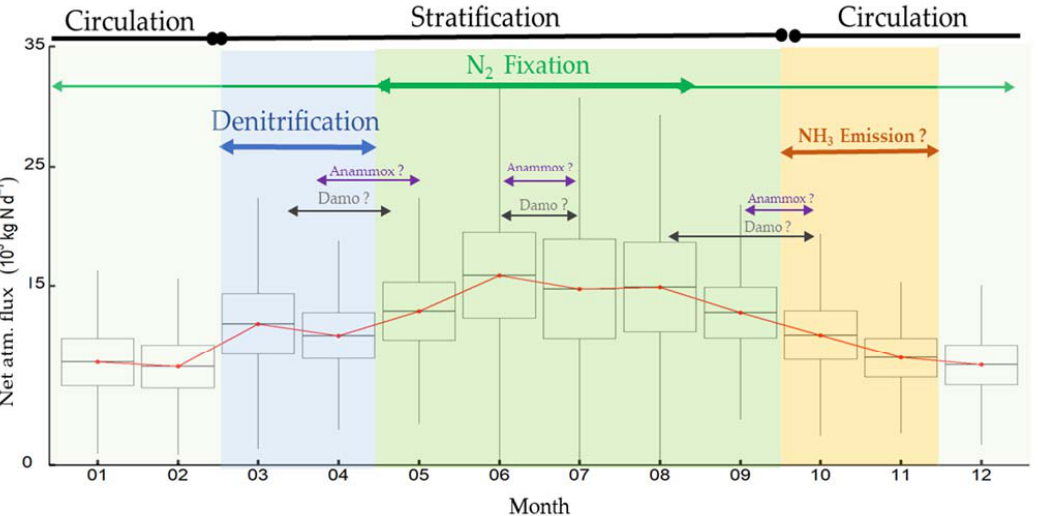
Figure 6. Relationships between net N atmospheric flux and: ( a ) water level, ( b ) volume of water mixed (Vmix) between the epilimnion and the hypolimnion, ( c ) DIN vertical flux to the epilimnion and ( d ) mean dissolved oxygen (DO) throughout the water column in VB for 2003–2018. Purple dots and numbers designate the years of the period with high WLF (H-WLF). The low WLF years are depicted by grey numbers and triangles. Linear regressions and correlations for both sets of years are also shown in the corresponding color. Vmix and DIN vertical flux adapted with permission and modeled from [33].